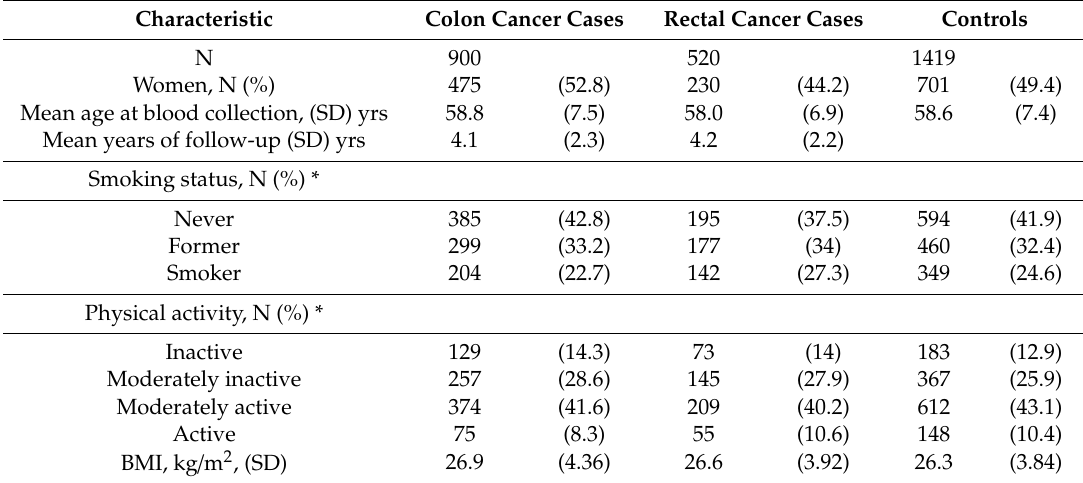
Table 1. Selected baseline characteristics of incident colon and rectal cancer cases and controls, the European Prospective Investigation into Cancer and Nutrition (EPIC) study, 1992–2003. Characteristic Colon Cancer Cases Rectal Cancer